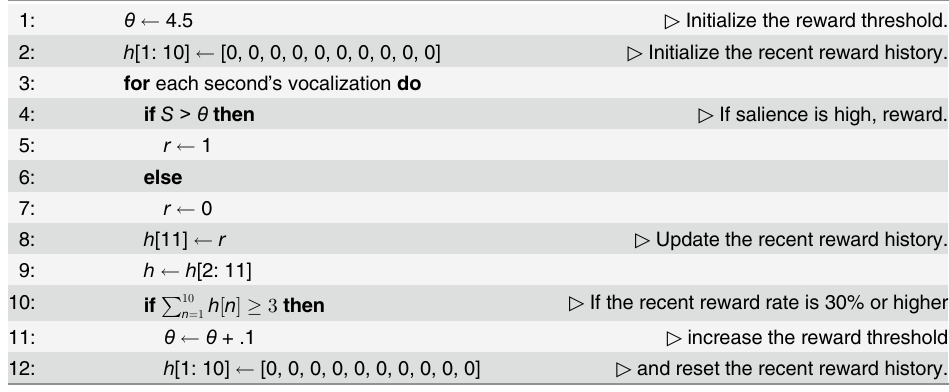
Algorithm 1. Adapting the reward